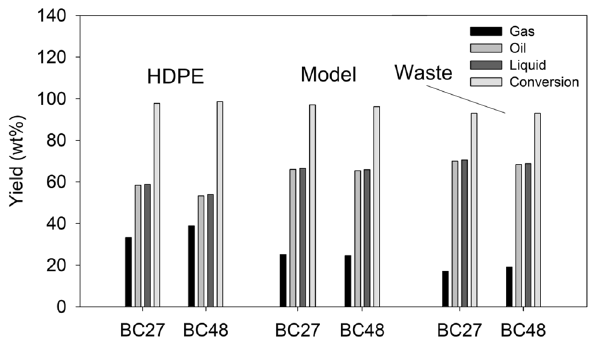
Fig. 11 Results of the catalytic hydroconversion reactions of indi- cated plastic materials over BC27 and BC48 catalysts. 500 ml auto- clave reactor, 20 bar initial cold hydrogen pressure, 60 min residence time, and 20:1 feed-to-catalyst ratio (by